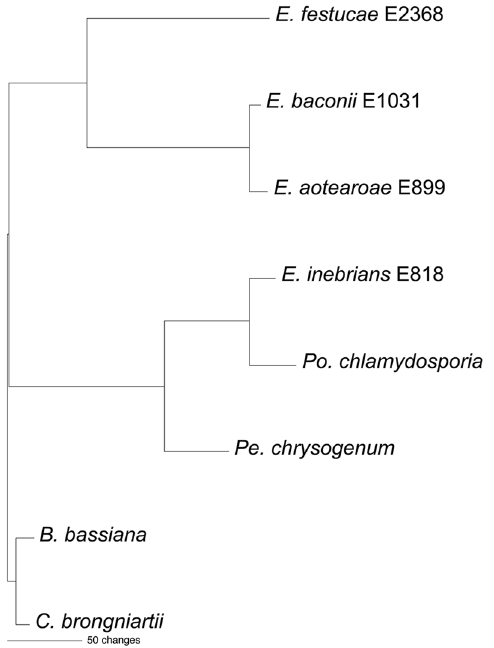
Figure 9. The single most parsimonious phylogenetic tree from an exhaustive search of antifungal protein gene DNA sequences (including introns). The B . bassiana and C . brongniartii sequences were designated as the outgroups for rooting the tree. The tree was based upon 435 total characters, of which 161 were constant, 55 variable characters were parsimony uninformative, and 219 variable characters were parsimony informative. NCBI accession numbers for the sequences are: B . bassiana ARSEF 2860, ADAH01000656; C . brongniartii RCEF 3172, AZHA01000055; E . aotearoae 1229, JFGX01000916.1; E baconii 200745, JFGY01002353.1; E . festucae E2368, ADFL02000476.1; E . inebrians E818, AMDK01000862.1; Pe . chrysogenum , U22944.2; Po . chlamydosporia 123,